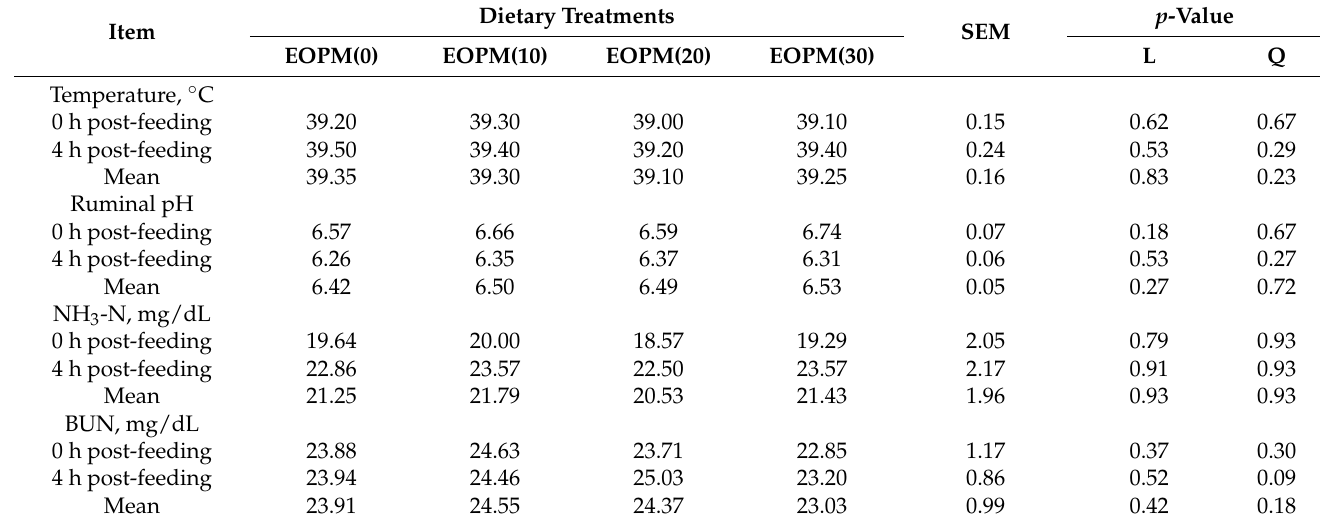
Table 4. Rumen fermentation of goats fed TMR diets containing extracted oil palm meal